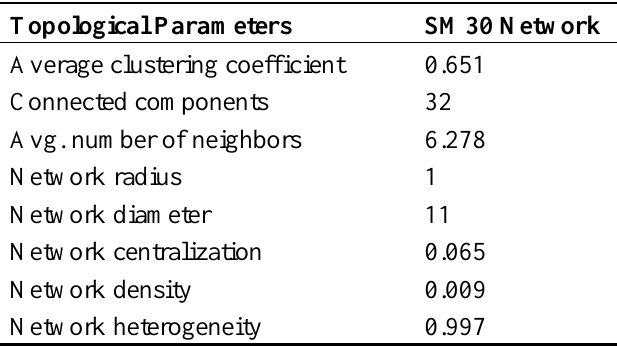
Table 4. Summary of the principal topological parameters estimated for the network sustained by up-regulated genes in cells treated with SM30